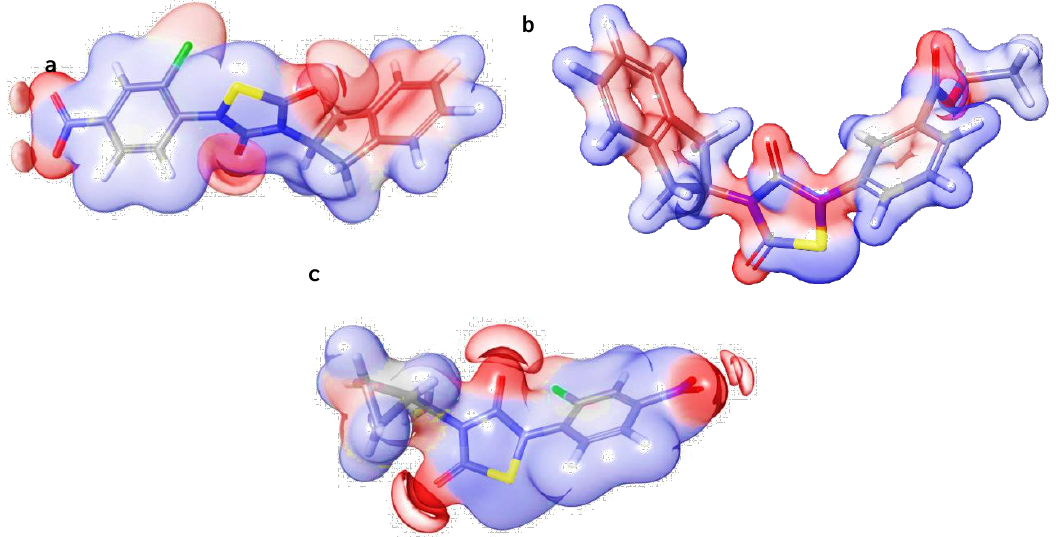
Figure S4. Surface electrostatic potential of inhibitors (a) 19 (b) 21 and (c) 25